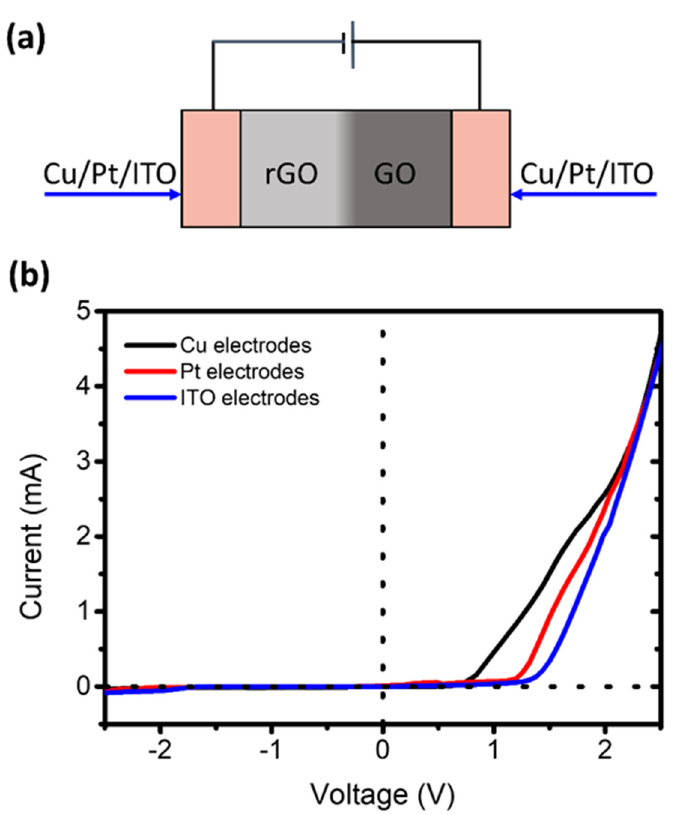
Figure 7. ( a ) Schematic of the pGO vertical p–n junctions measured with copper electrodes, Pt electrodes, and ITO electrodes, respectively. ( b ) I–V curves of the pGO vertical p–n junctions measured with copper electrodes, Pt electrodes, and ITO electrodes, respectively.